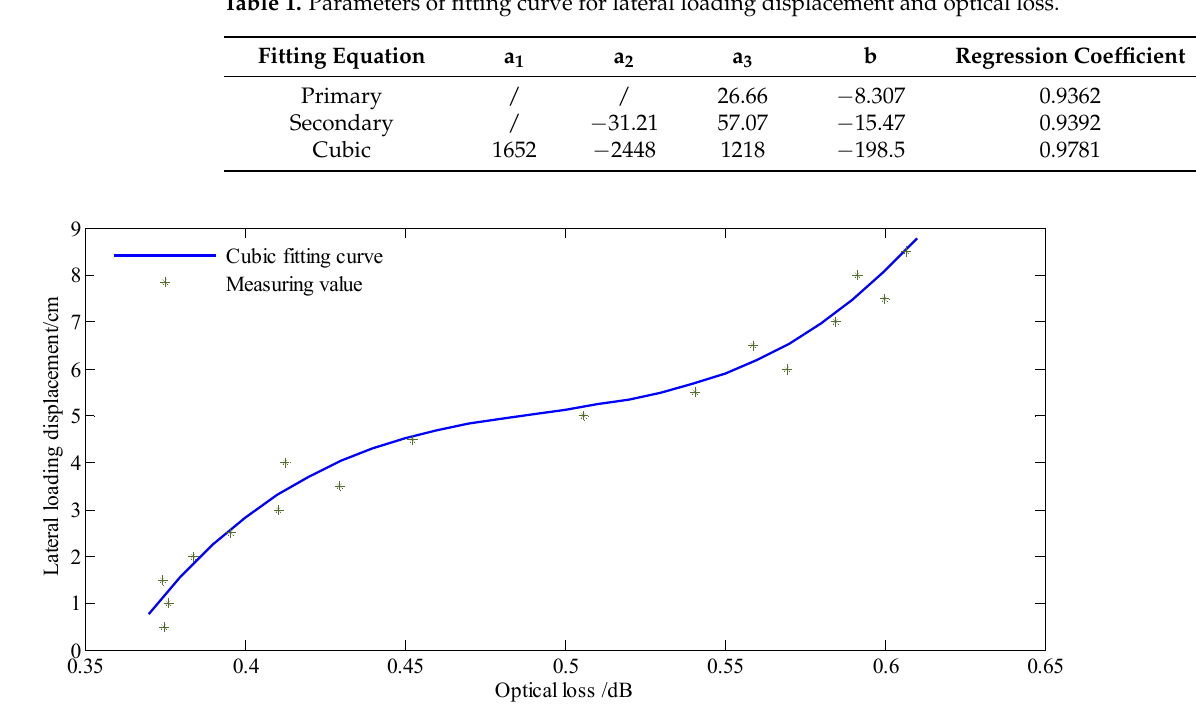
Figure 10. Cubic fitting curve for lateral loading displacement and optical loss.